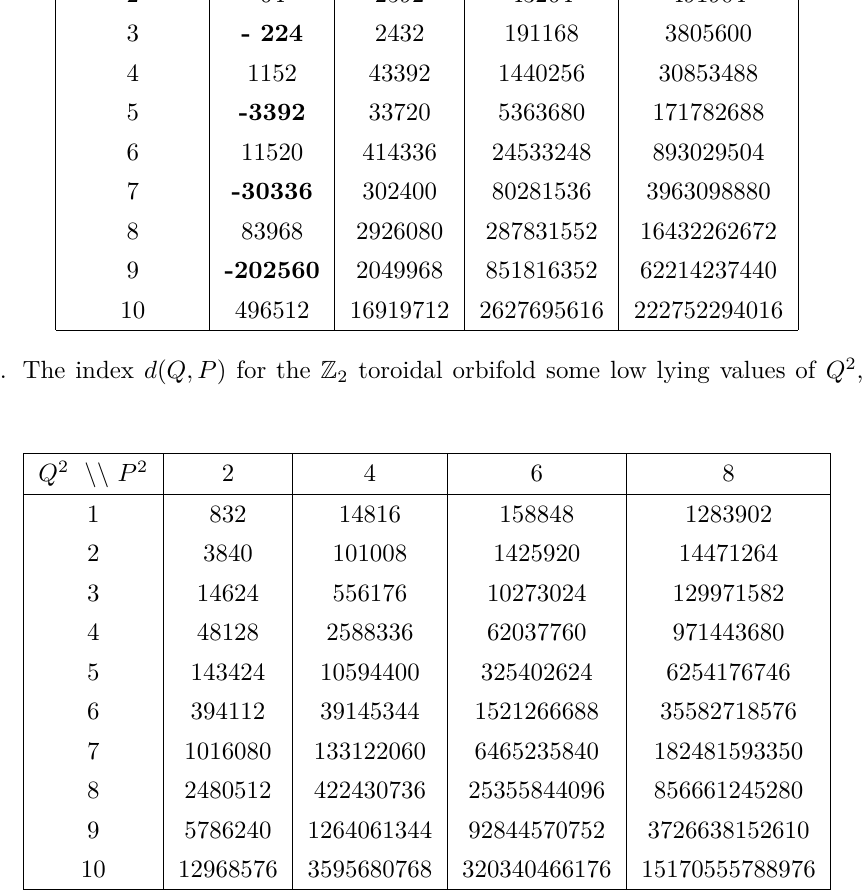
Table 19 . Index of horizon states for the Z 2 orbifold of T 6 for Q · P = 0 .